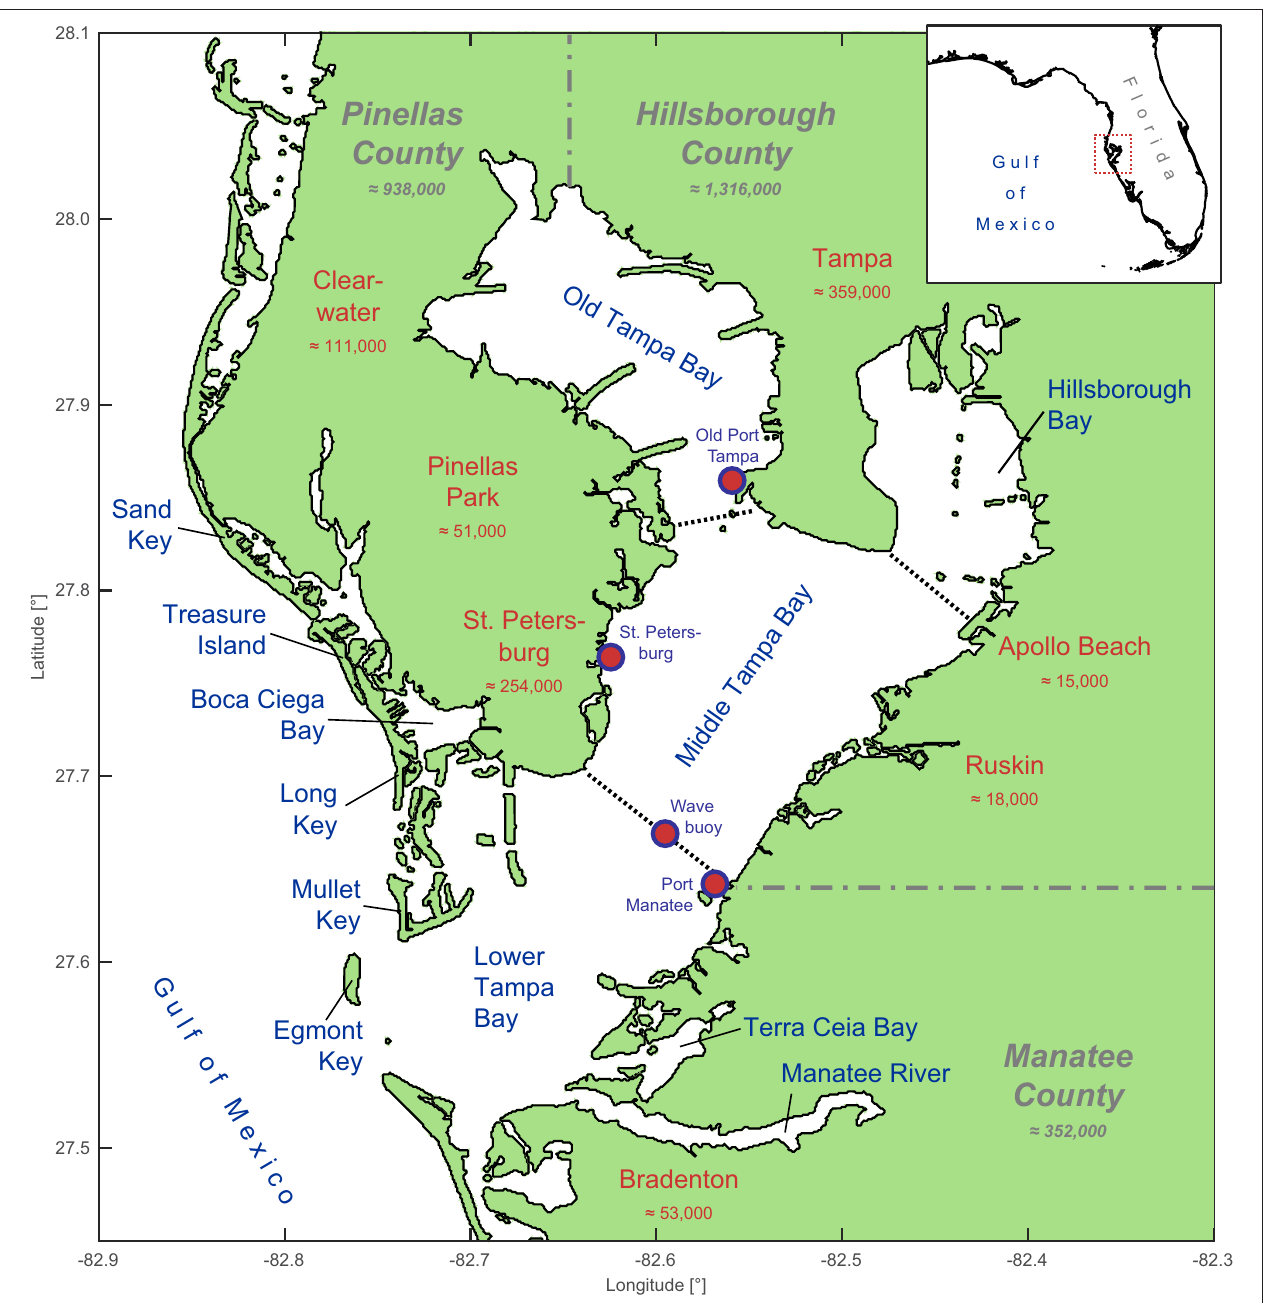
FIGURE 1 | Map of Tampa Bay with its bay sections as well as adjacent cities and counties with 2014 population estimates (from United States Census Bureau); tide and wave gauges are marked as red dots.